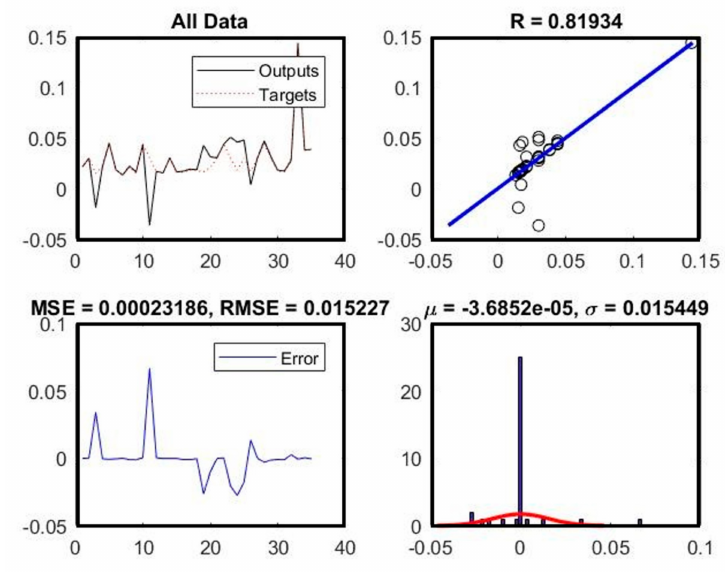
Figure 4. Error and R-value results for all data.